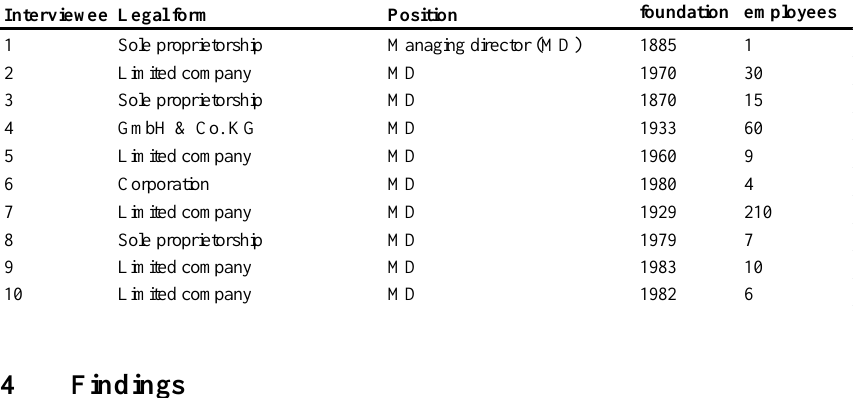
Table 1 . Demographic characteristics of the